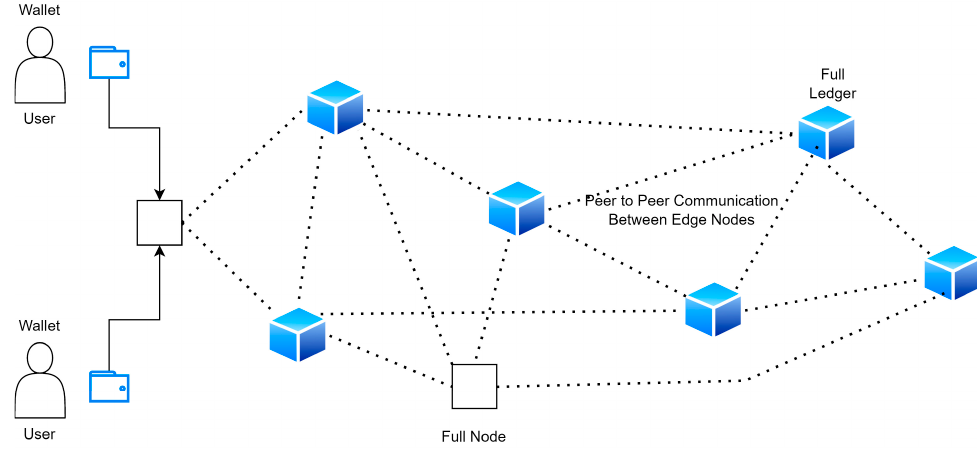
Figure 4. Proposed P2P communications.